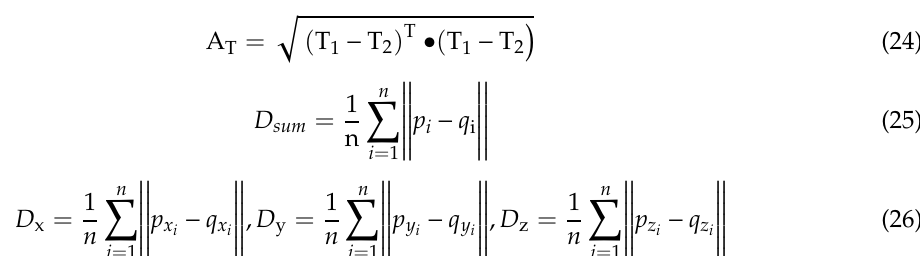
Table 2. Number and efficiency of keypoint extraction.